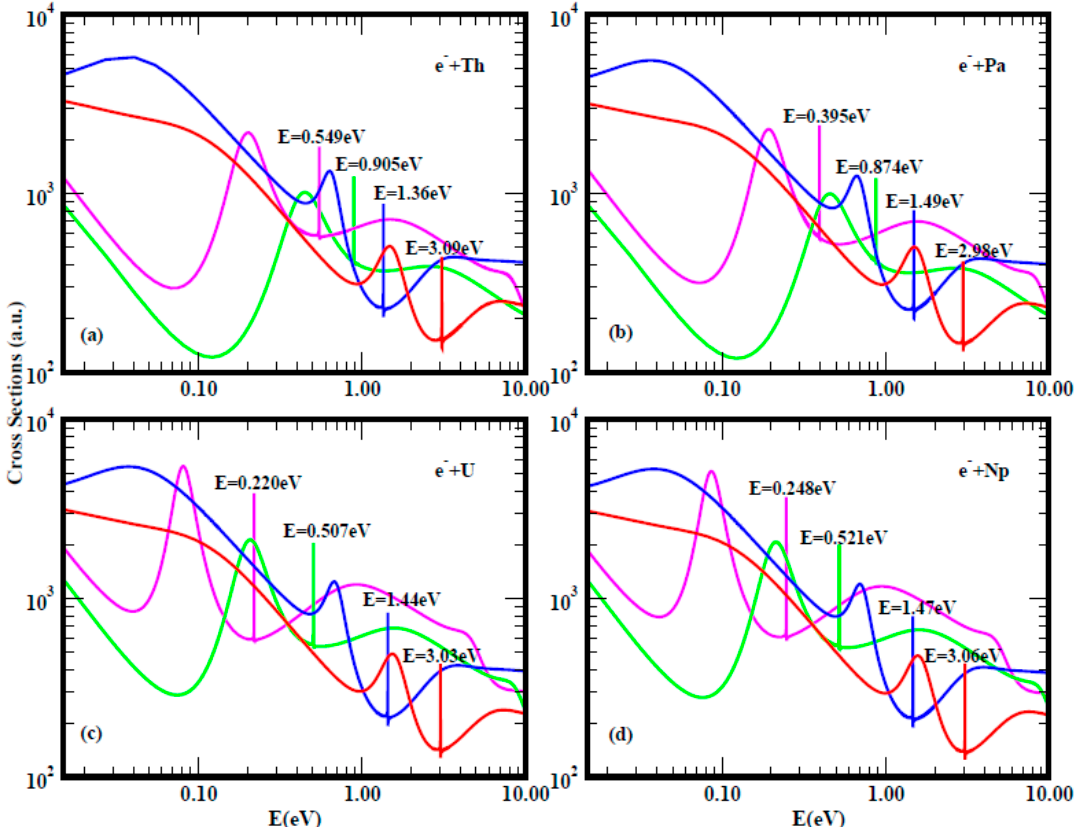
Figure 2. Total cross sections (a.u.) for electron elastic scattering from atomic Th(a), Pa(b), U(c) and Np(d). The red, blue, green and pink curves represent TCSs for the ground, metastable and two excited states, respectively. The dramatically sharp resonances in the figures correspond to the Th ˉ , Pa ˉ , U ˉ and Np ˉ negative ions formation during the collisions.